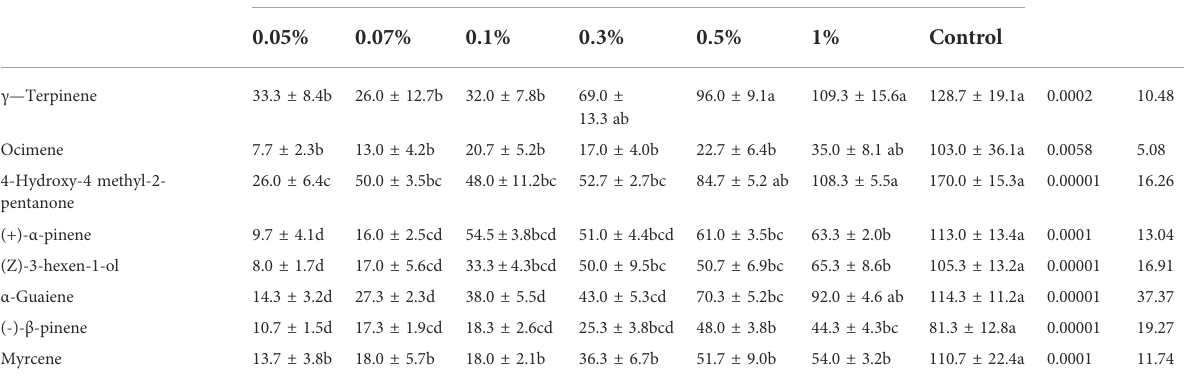
FIGURE 6 Olfactometric Preference Index (OPI) of white fl y, Bemisia tabaci in response to cotton plant extracts of different stages and synthetic plant volatiles. Plant extract (10 µl) or Synthetic compound (10 µl of 0.1% solution) was used as a stimulus. Means with different letters are signi fi cantly different (F 9.30; df 11; p < 0.00001). OPI values ranged from 0 to 2 (OPI = 1-no olfactometric preference for odor source or control; OPI > 1- preference for treatment odor source arm; OPI < 1-preference for control arm). The analysis was done using STAR software. The extract/compound number represent 1:Upward curled leaves extract; 2: Downward curled leaves extract; 3: Enation